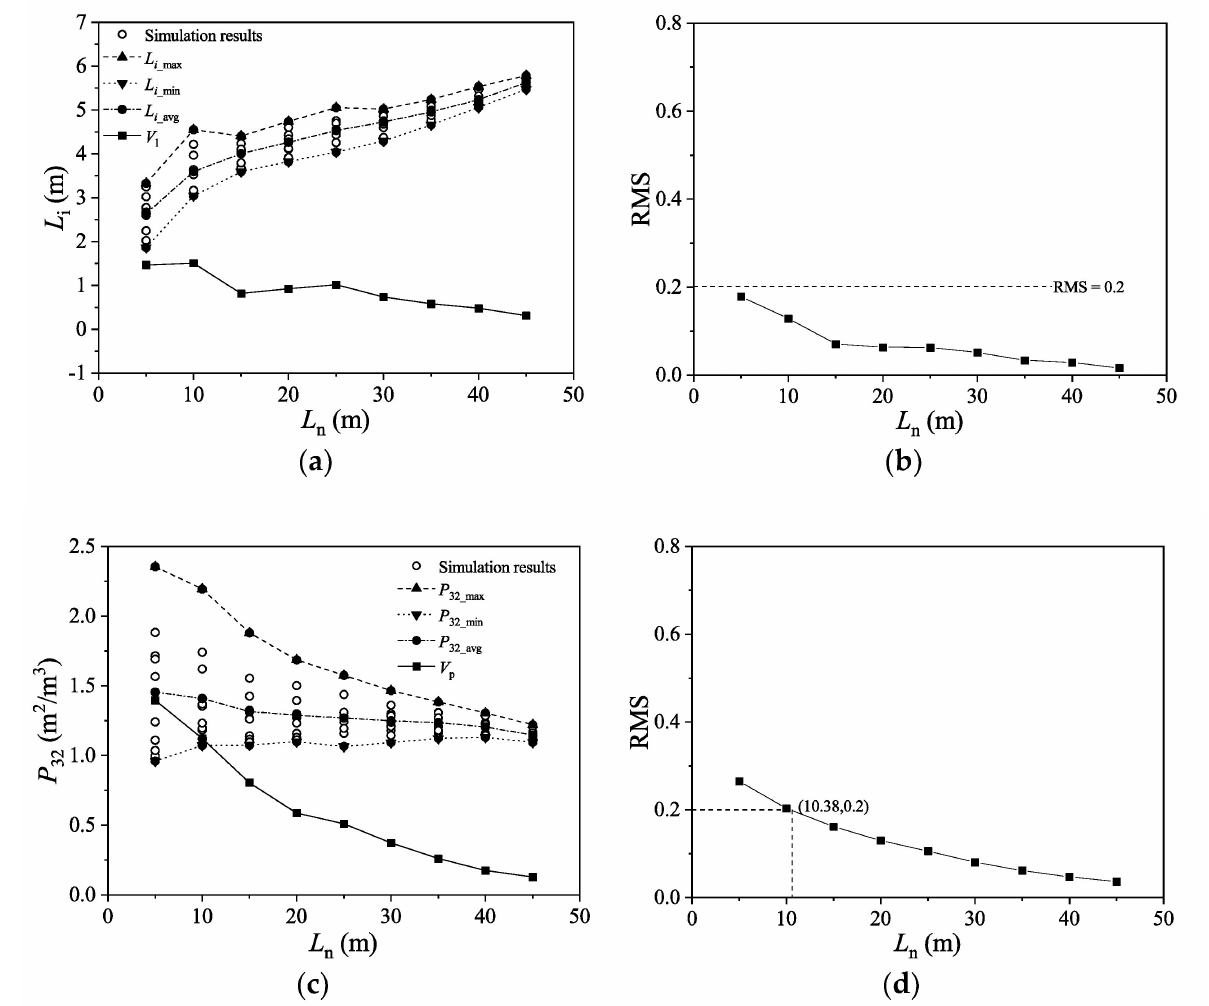
Figure 13. Variations in P 32 and L i with increasing L n . ( a ) Relationship between L i and L n ; ( b ) Rela- tionship between RMS of L i with L n ; ( c ) Relationship between P 32 and L n ; ( d ) Relationship between RMS of P 32 with L n